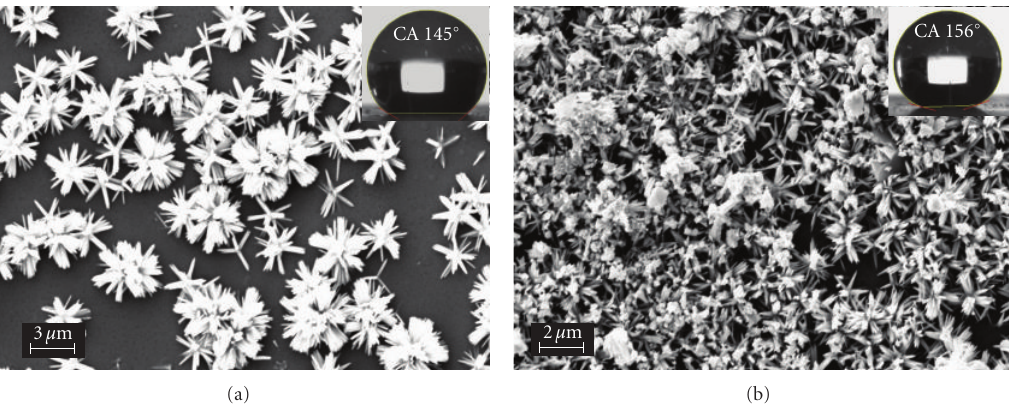
Figure 2: Surface morphology of ZnO coating immersed in stearic acid (a), ZnO heat treated at 70 ◦ C and immersed in stearic acid (0.002M) (b). Insets show the profiles of the water droplet on the film